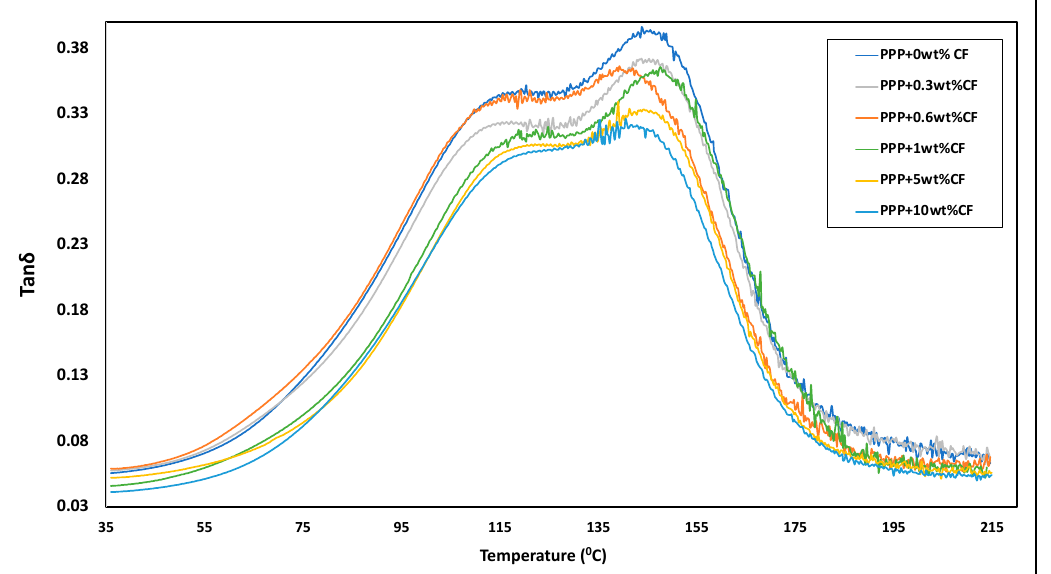
Figure 8. DMA test result of PPP/CF composites; effect of CF content in SLS-Printed fully cured thermosetting samples on loss modulus.